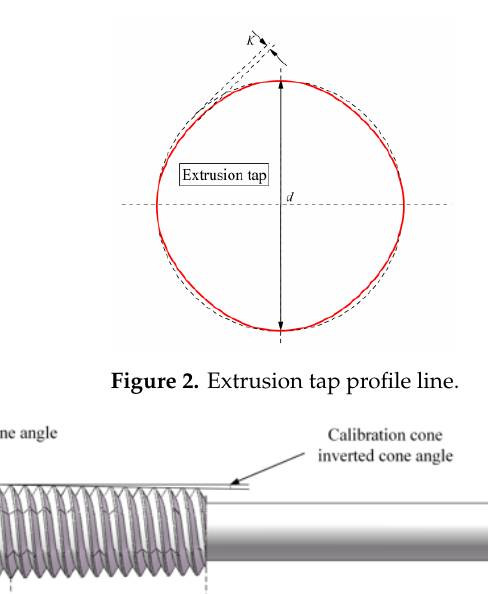
Figure 2. Extrusion tap profile line.